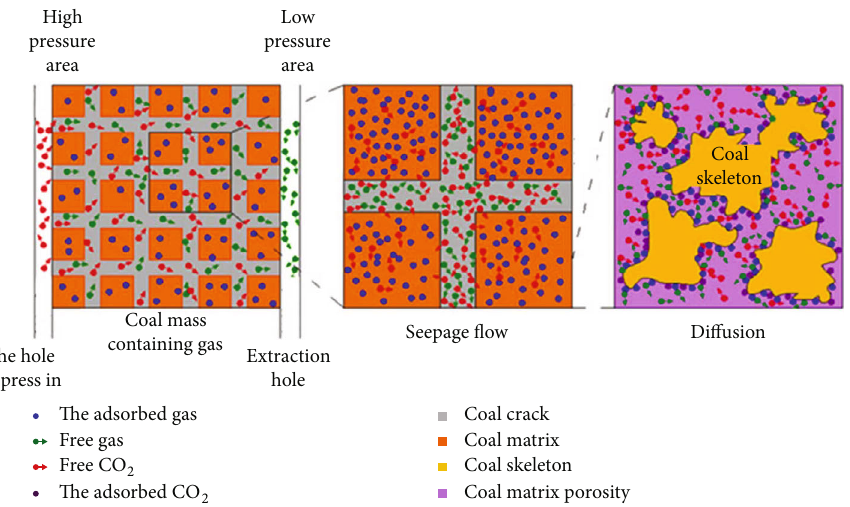
Figure 1: Chart of CH